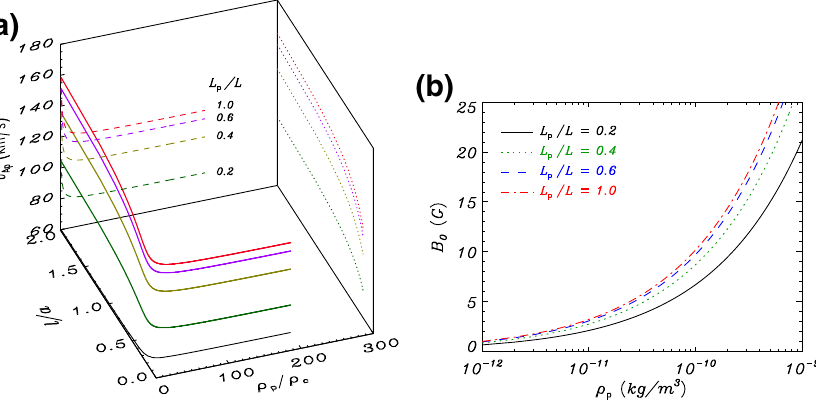
Fig. 86 Determination of a prominence Alfvén speed and b magnetic field strength from the computation of periods and damping times for standing kink oscillations in two-dimensional prominence thread models and observations of period and damping times in transverse thread oscillations. The observed period and damping time are 20 and 60 min, respectively, and L = 10 5 km. Image reproduced with permission from Soler et al. (2010b), copyright by